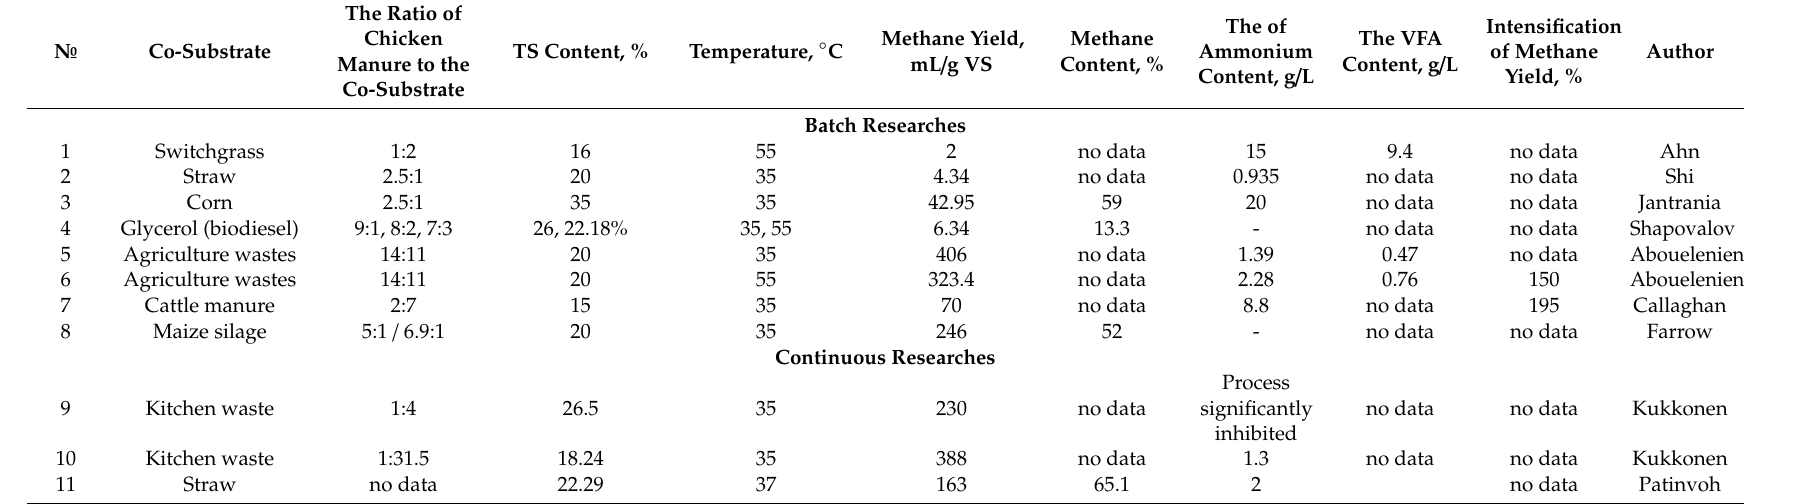
Table 4. Comparison of the co-fermentation of chicken manure with other